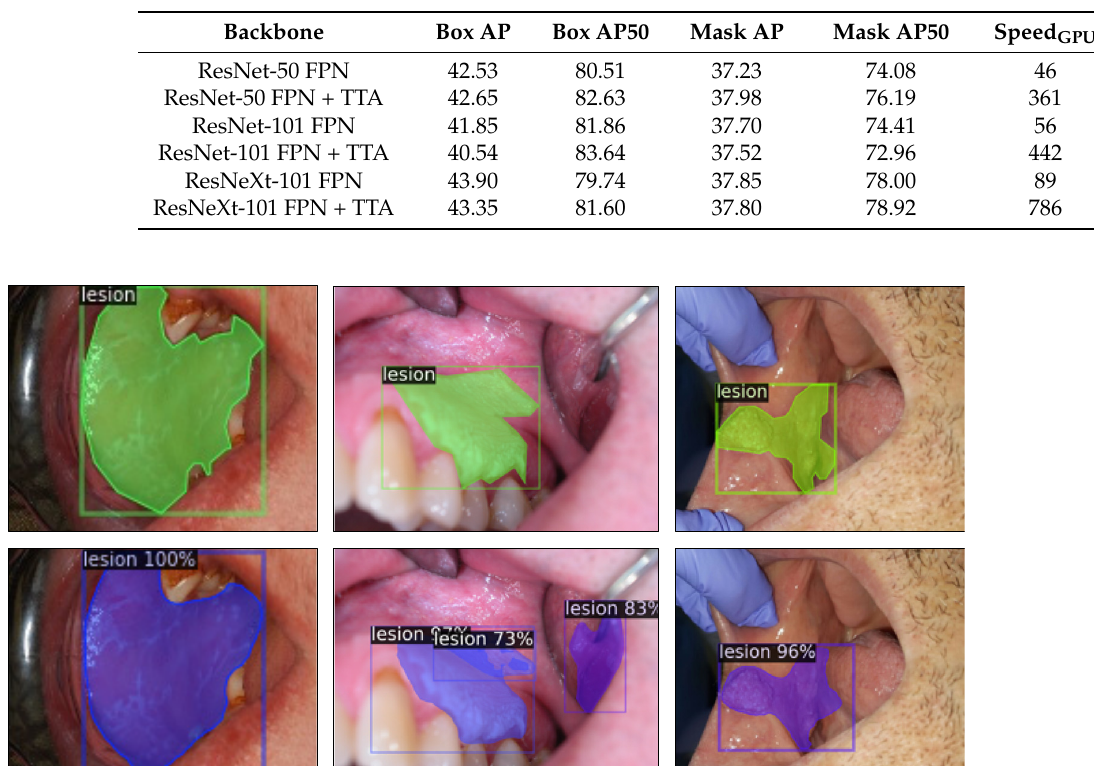
Table 4. Mask-RCNN results on test set with ResNet-50, ResNet-101, and ResNeXt-101 FPN back- bones. The results are provided with and without TTA. Speed GPU measures per image inference speed in milliseconds (ms) using one Tesla T4 GPU and includes image pre-processing, inferenc- ing, post-processing and NMS.